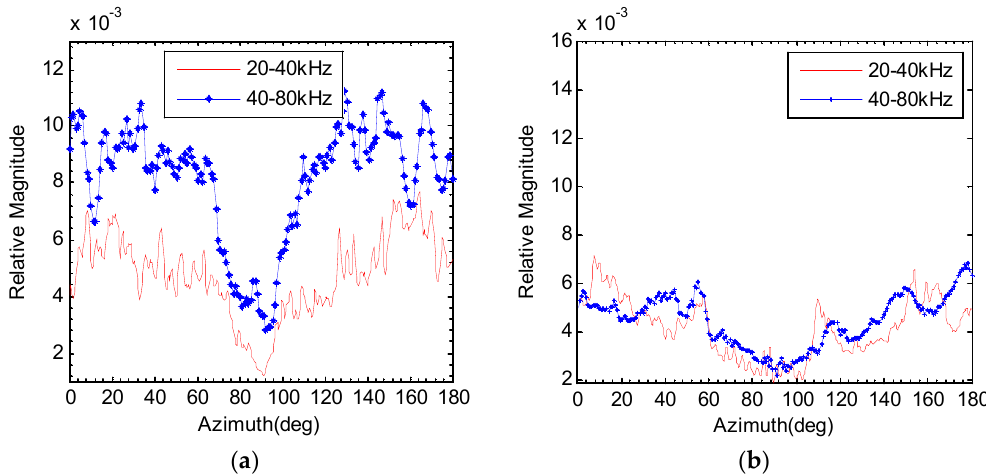
Figure 20. ( a ) Fluctuation intensity comparison of the real target wideband echo envelope with different frequencies, the pulse length is 3 ms; ( b ) fluctuation intensity comparison of the synthetic wideband echo envelope with different frequencies, the pulse length is 3 ms.